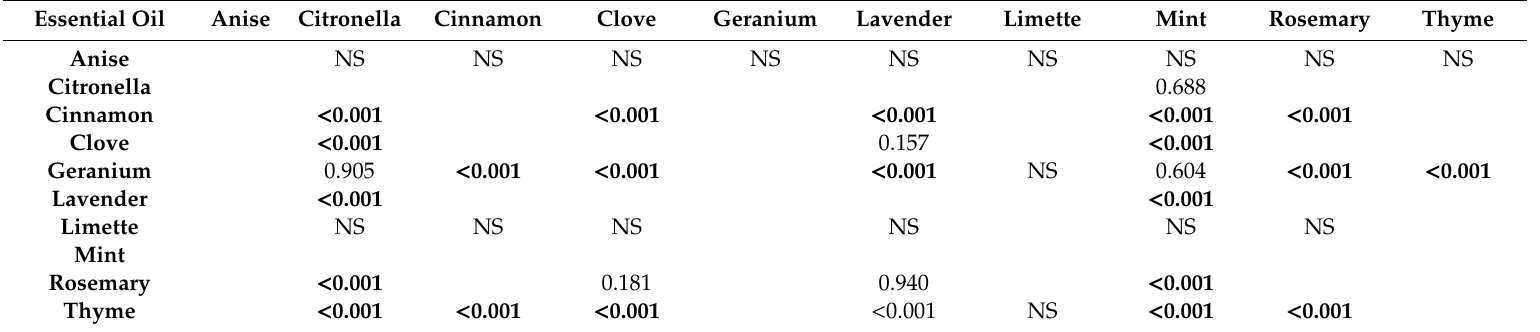
Table A1. Levels of statistical significance ( p ) in Fisher’s post-hoc test of EOs activity against S. mutans.